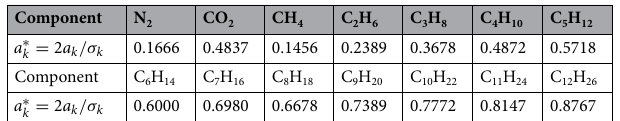
Table 5. Value of a ∗ k obtained from the second virial coefficient data fitting.